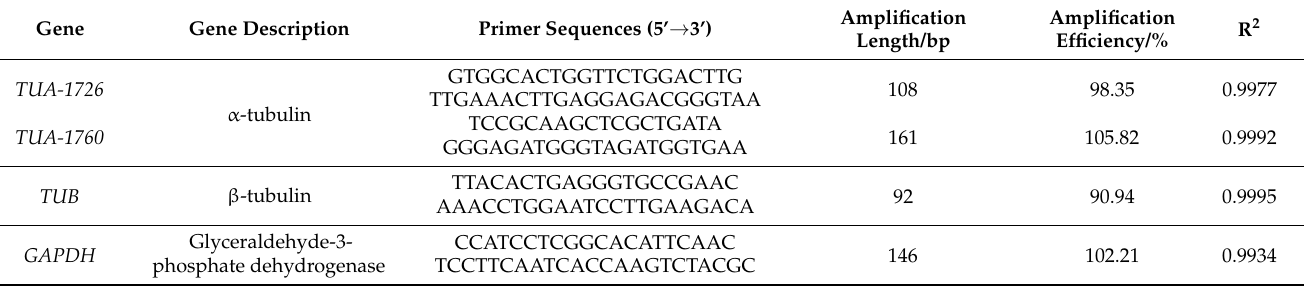
Table 1. Analysis of S. ferganica internal reference genes, primer information, and PCR amplification